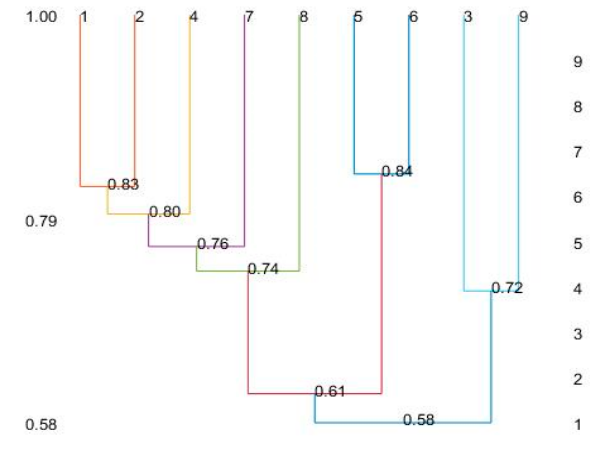
Figure 2. Cluster analysis diagram.